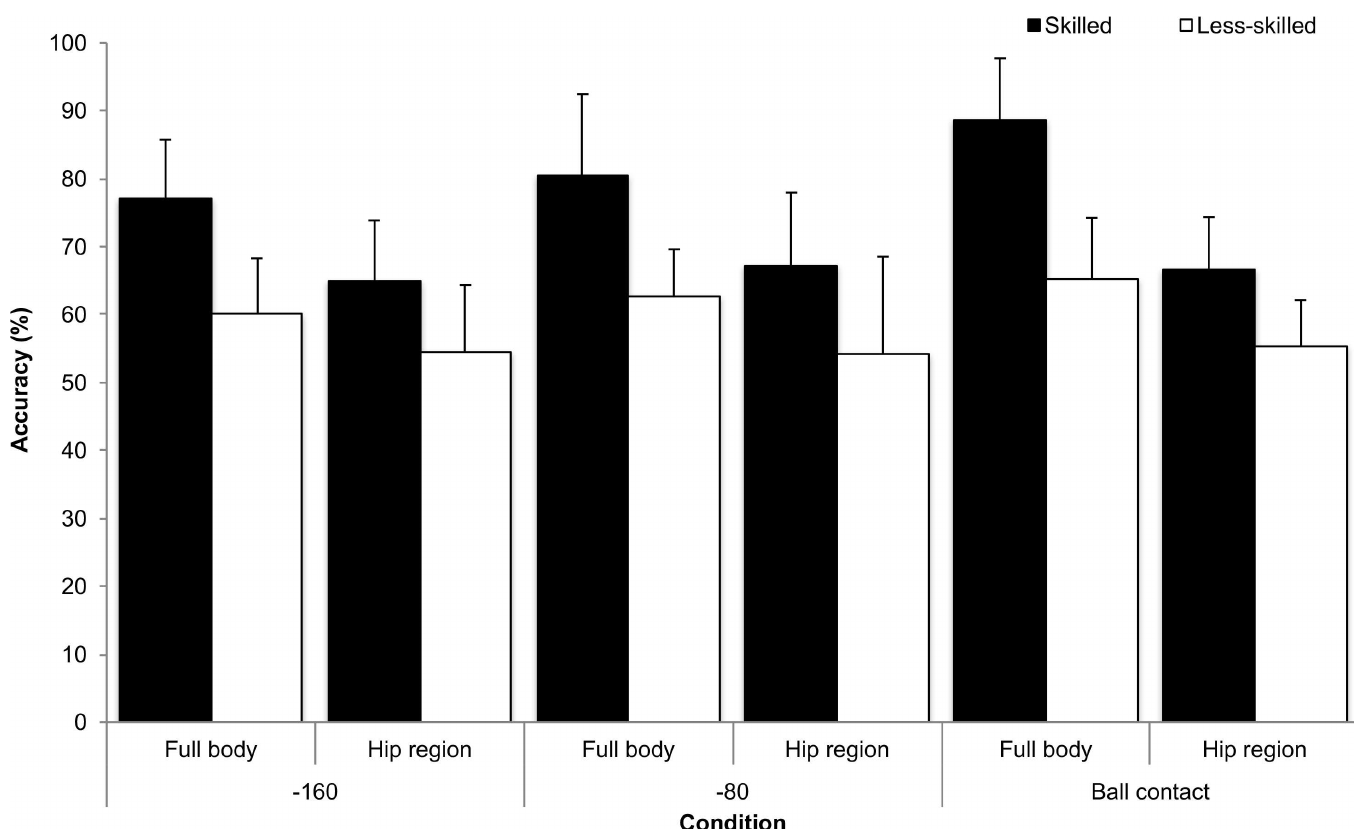
Fig 4. Correctheight (%; SD) for the skilled and less-skilled groups in the full body and hip region spatial occlusion conditions and for the -160, -80 and ball contact temporal occlusion conditions.